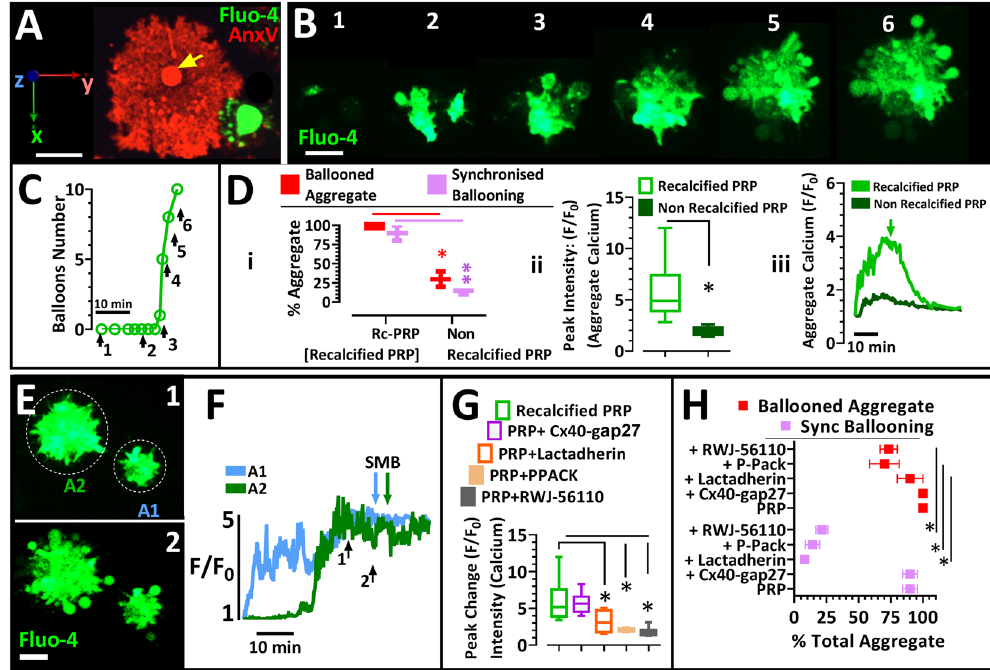
Figure 1. Human platelet aggregation in platelet-rich-plasma is characterised by synchronous membrane ballooning and is extracellular calcium-dependent. ( A ) Platelets in re-calcified platelet-rich plasma (Rc-PRP) were labelled with the calcium indicator Fluo-4 and allowed to adhere to collagen-coated surface. Superimposed extended focus images of Alexa568-Annexin-V (AnxV, red) and Fluo-4 (green) show the presence of a ballooned and procoagulant-spread (BAPS) platelet (red), yellow arrow points to the ballooned part of this platelet. ( B ) Platelets in Rc-PRP labelled with Fluo-4, undergo synchronised membrane ballooning (SMB) as they aggregate on collagen matrix. Numbers relate to arrows in C. Related to Movie S1 ( C ) Number of balloons formed over time in representative aggregate from B. Numbered arrows correspond to numbered images in B. ( D ) The absence of extracellular Ca 2 + (with non-recalcification) blocks synchronous membrane ballooning. D-i, percentage of aggregates which showed SMB relative to aggregates with ballooned platelets at 1 hr. D-ii, peak Ca 2 + intensity (F/F 0 ) of aggregates. D-iii, calcium fluxes of representative aggregates with time. Green arrow indicates point of SMB in re-calcified PRP. ( E ) Aggregate formation of Fluo-4-labelled platelets in Rc- PRP. Images show platelet aggregations at time points corresponding to numbered arrows in ( F ), which shows calcium fluxes of aggregate numbers A1 and A2. Coloured arrows indicate onset of SMB. ( G & H ) Platelets in Rc-PRP were labelled with Fluo-4 and allowed to adhere to a collagen-coated surface for 1 hr. ( G ) Peak change in cytosolic calcium is shown, in absence or presence of connexin40 inhibitor (Cx40-GAP27; 100 g/ml), 2% v / v lactadherin, 100 µ M PPACK or 50 µ M RWJ-56110. ( H ) Percentage of total aggregates, showing SMB or total ballooning (i.e. synchronised plus non-synchronised). Charts in Di, Dii, G and H show interleaved box plots with whiskers showing minimum to maximum values, median, and interquartile range. Data analysis was by Wilcoxon Signed Rank Test (D-i) or Friedman test, followed by Dunn’s multiple comparison test (G,H). * P < 0.05 was considered significant. Scale bars in A, B and E represent 5 μ m. Data were from 10–15 aggregates (of 7–40 platelets) per view; and 35 ± 5 aggregates were analysed for each of 5 donor blood